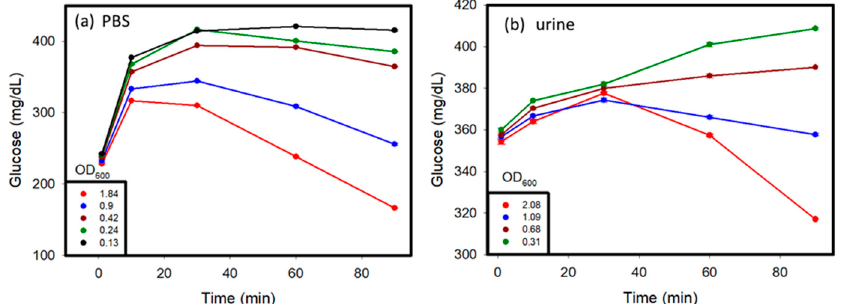
Figure 5. Glucose added to urine before testing, showing ( a ) glucometric responses with different OD 600 values taken before testing C. albicans over time in PBS and ( b ) glucometric responses with different OD 600 values taken before testing C. albicans in urine, when glucose was initially added to the sample before testing.